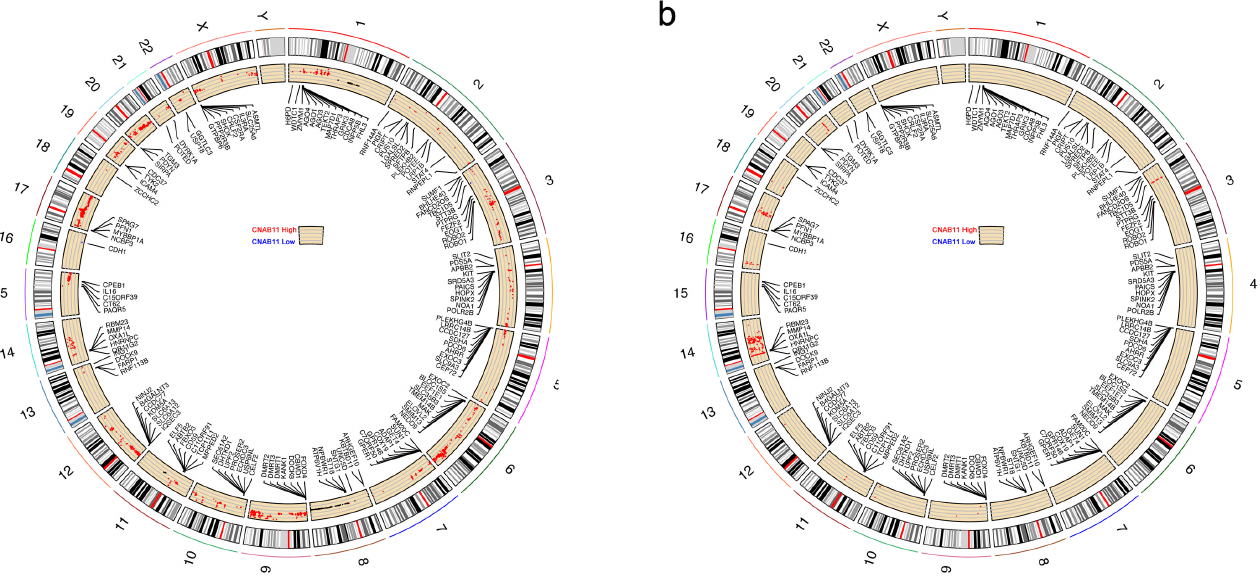
Figure 5. The differential CNA between the CNAB11-high and CNAB11-low populations in ( a ) the TCGA cohort and ( b ) the CICAMS